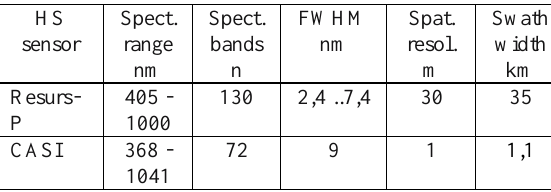
Table 1. Hyperspectral sensor characteristics. FWHM – full width at half